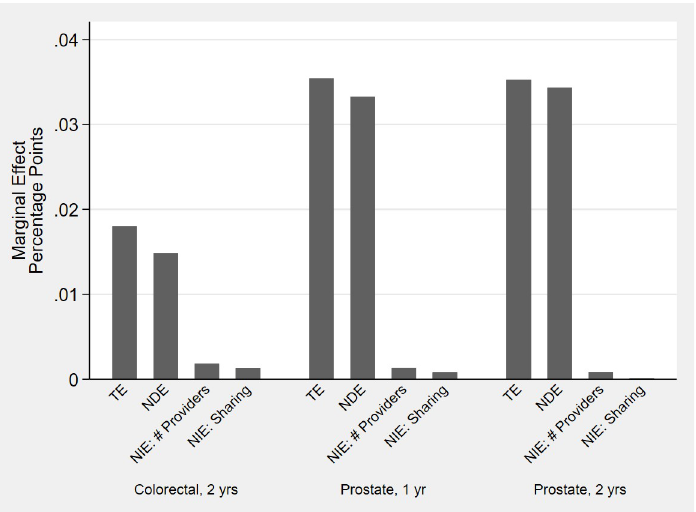
Fig 5. Effects of cancer on proportion adherent (proportion of days covered > 80%) for anti-hypertensives: Total Effect (TE), Natural Direct Effect (NDE) and Natural Indirect Effect (NIE) through number of providers and sharing amongst providers. Point estimates, in percentage point changes, for cancer sites and phases of care with statistically significant total and net indirect effect.